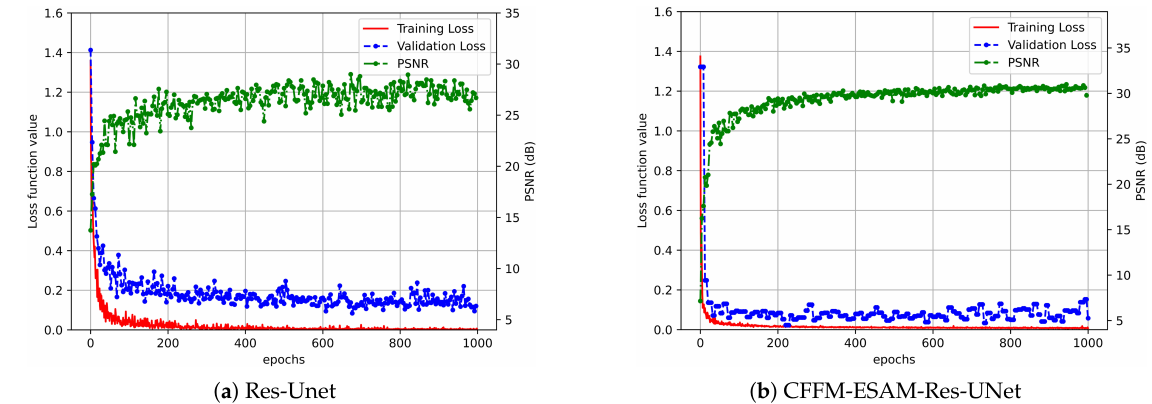
Figure 6. The value of the hybrid loss function during the network